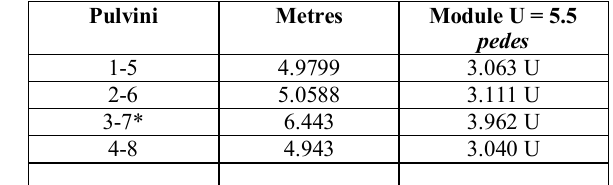
Table 3. Radii extracted with vertical planes passing through opposite preserved travertine pulvini (white numbers in